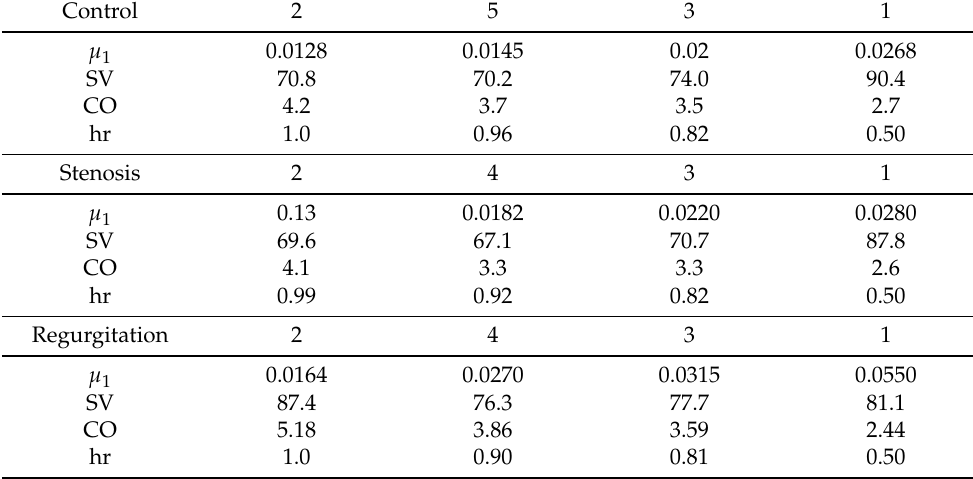
Table 6. Effect of µ 1 with a severe aortic valve stenosis or regurgitation. Refer to Table 4 for severity. µ 1 increases from left to right. The headings 2, 4 or 5, 3, and 1 denote the number of P-V loops appearing in the P-V plot as µ 1 is increased. The results given in the µ 1 rows give the values of µ 1 at which the 2, 4 or 5, 3, and 1 P-V loops are observed. SV, CO, and hr rows likewise provide the stroke-volume, cardiac output, and heart rate measured at that value of µ 1